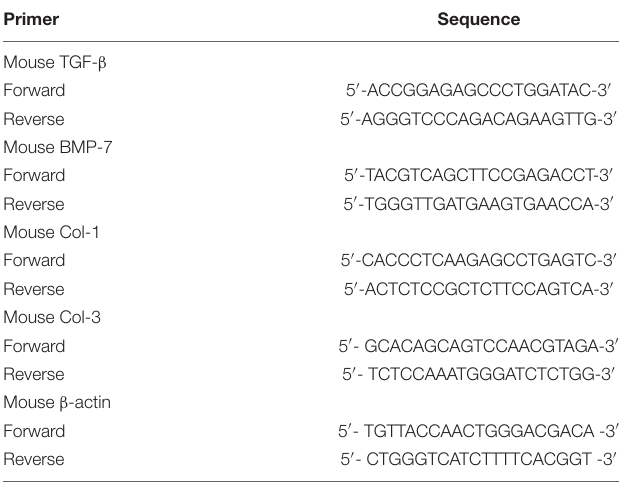
TABLE 1 | Primer sequences for qPCR analysis of mouse samples.